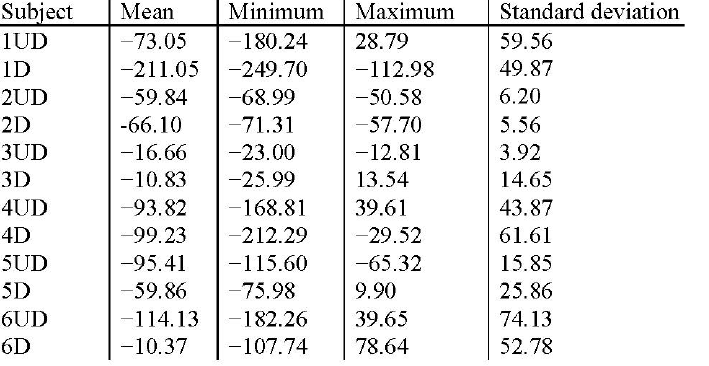
Table 3: The mean C